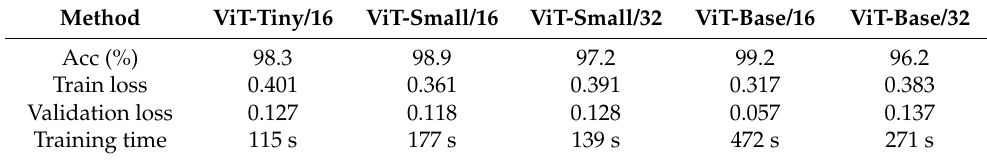
Table 1. Performance in ViT training.